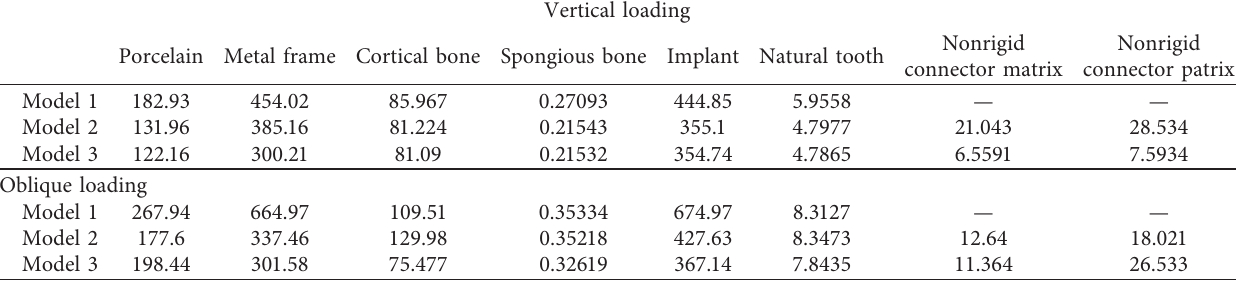
Table 2: Maximum values of von-Mises stress (MPa) in the models with vertical incisal loading and oblique loading to the cingula. Vertical loading Porcelain Metal frame Cortical bone Spongious bone Implant Natural tooth